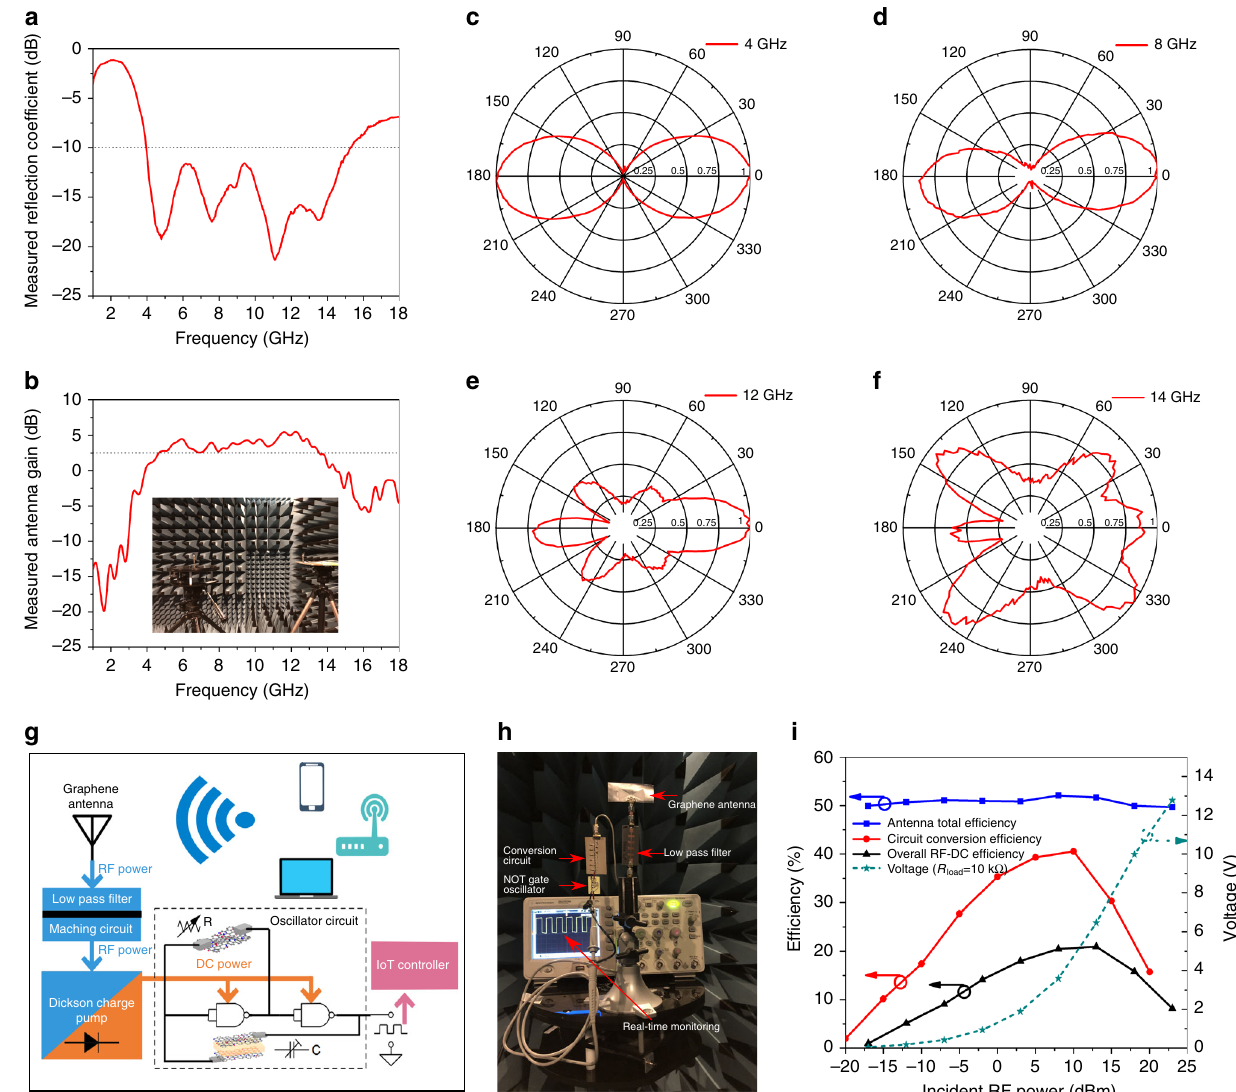
Fig. 5 Printed graphene wideband slot antenna for RF energy harvesting application. a Measured re fl ection coef fi cient ( S 11 ) of the slot antenna. b Measured antenna gain (three-antenna method). c – f Measured radiation pattern at 4 GHz ( c ), 8 GHz ( d ), 12 GHz ( e ) and 14 GHz ( f ). g – i Demonstration of RF energy harvesting application ( g illustration of RF energy harvesting system, h measurement set up and i measured ef fi ciencies and output DC voltage as a function of different RF power